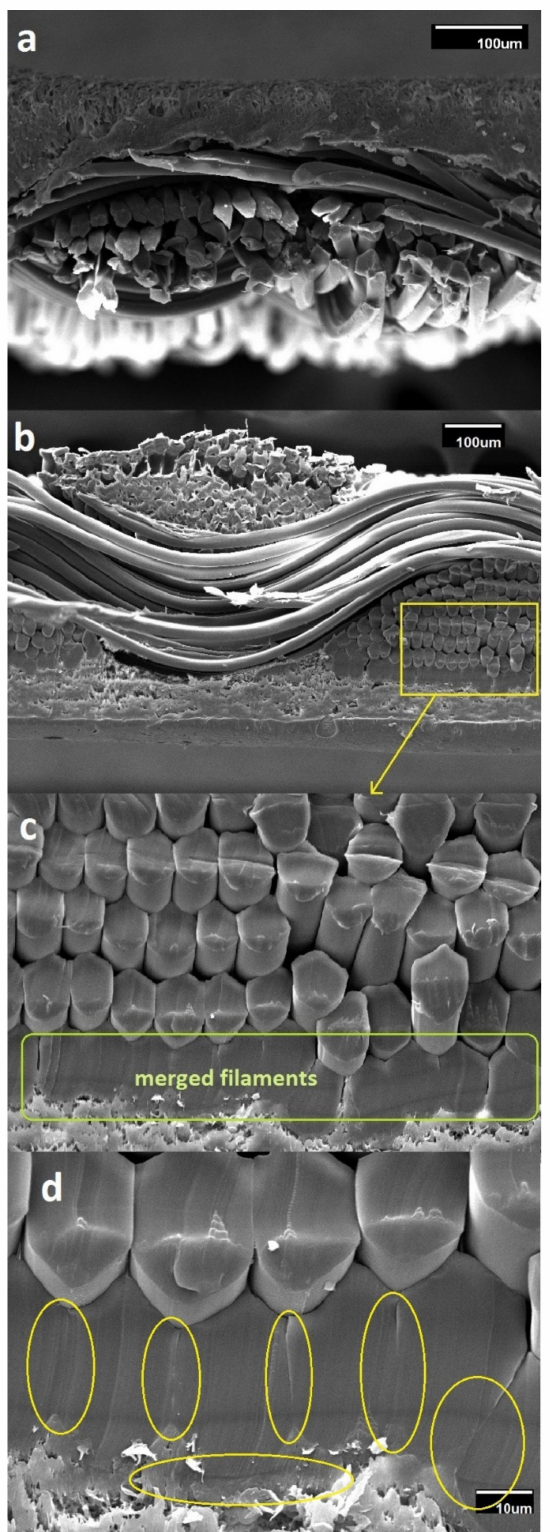
Figure 3. Cross-sectional SEM picture of PVCCF ( a ) and APCCF ( b , c ). The fused parts are shown with the yellow ovals ( d ). In PVCCF, the adhesion is not homogeneous and strong while in APCCF, the first row of the fibre-filaments of the PA fabric are merged together and adhered to the coating. It will decrease the chance of delamination in a long span of